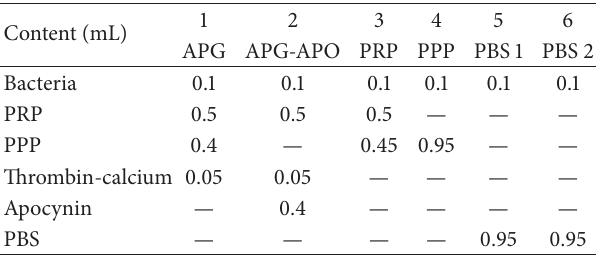
Table 1: Components of each